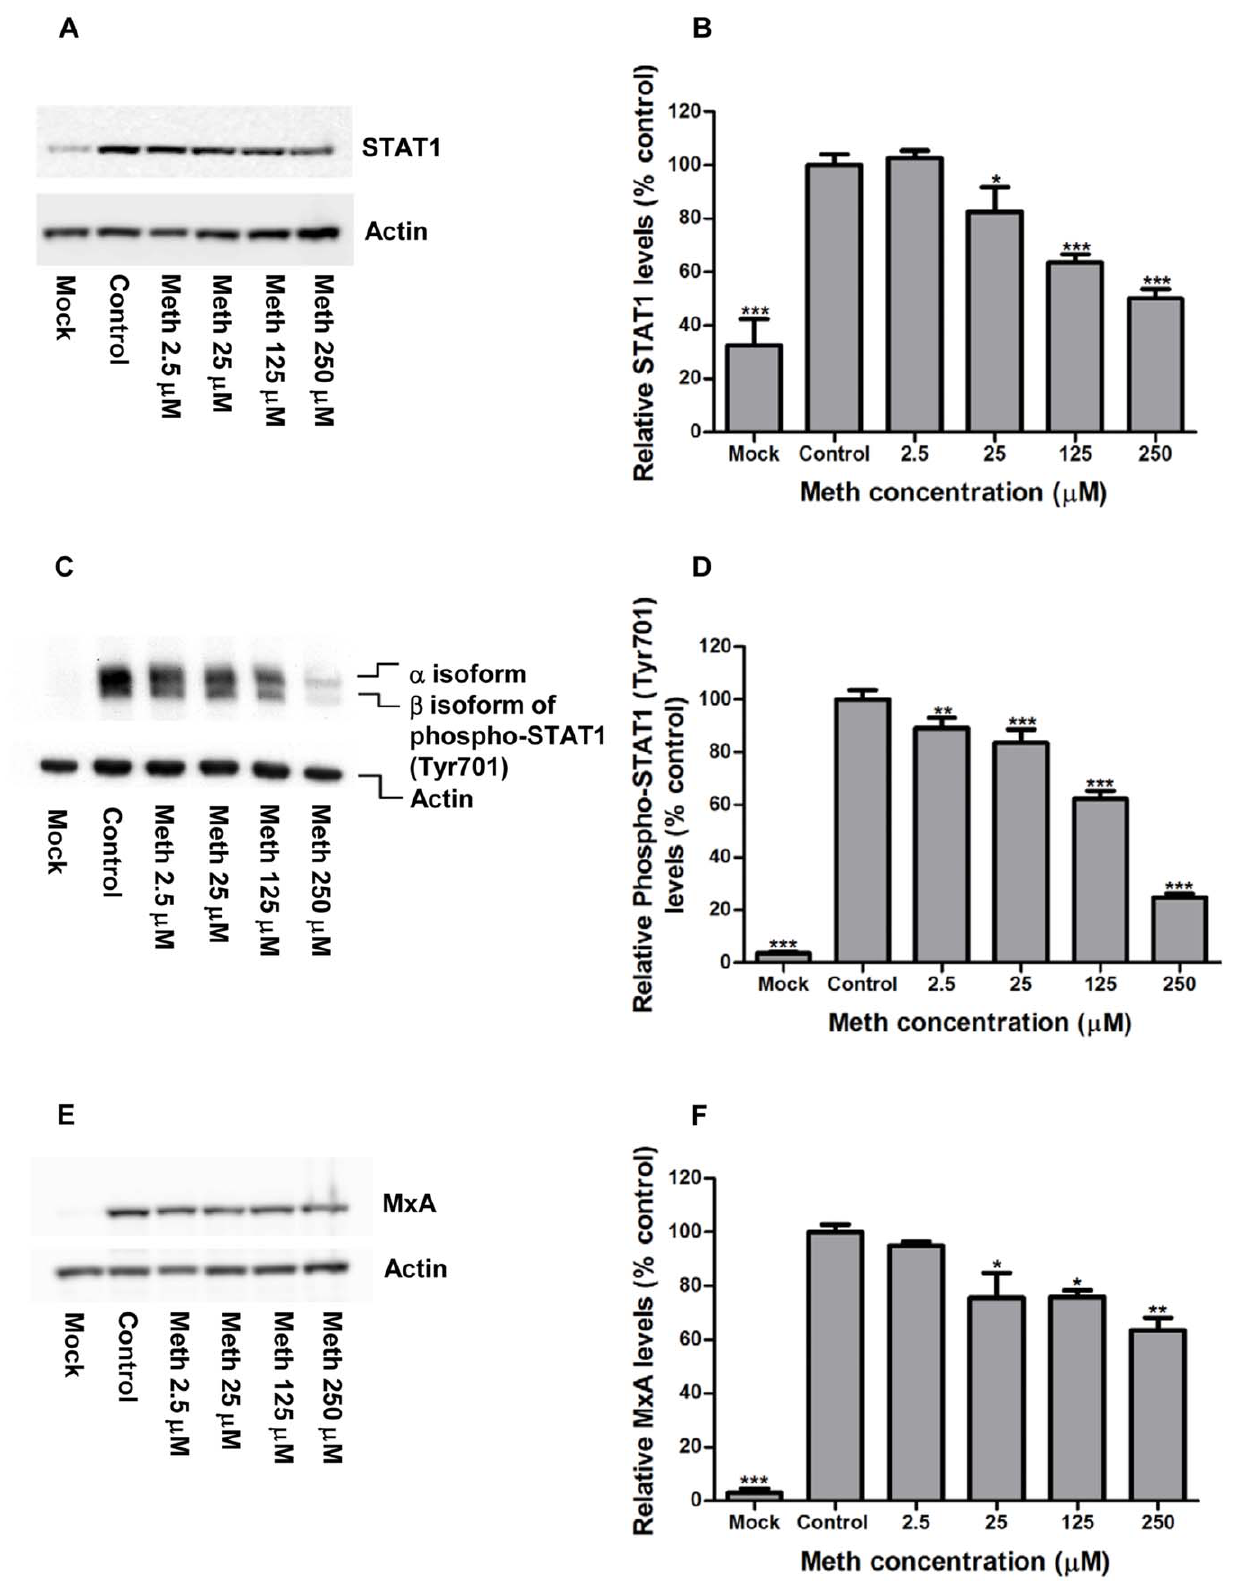
Figure 8. Effects of meth on influenza infection-induced IFN responses in human lung epithelial A549 cells. A549 cells were left untreated (control) or treated with meth at indicated concentrations for 24 h, followed by infection with human influenza virus strain A/WSN/33 (H1N1) at an MOI of 0.001 PFU/cell in the presence of trypsin (multi-cycle growth) and meth at respective concentrations. At 48 h post-infection,